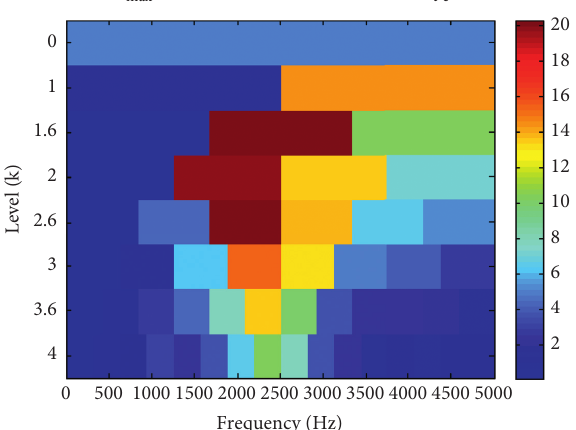
Figure 7: Fast kurtogram of low resonance component of x .